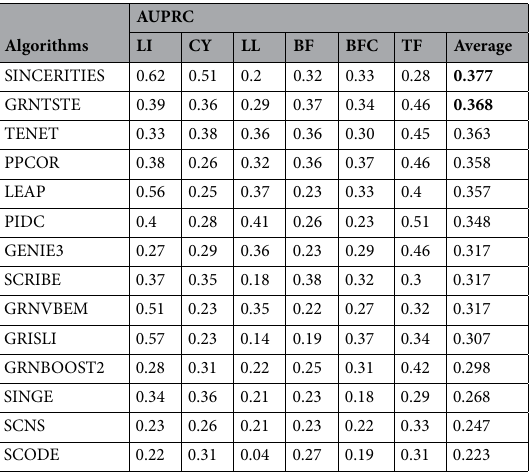
Table 4. The AUPRC for BEELINE datasets with different types. Significant values are in bold.